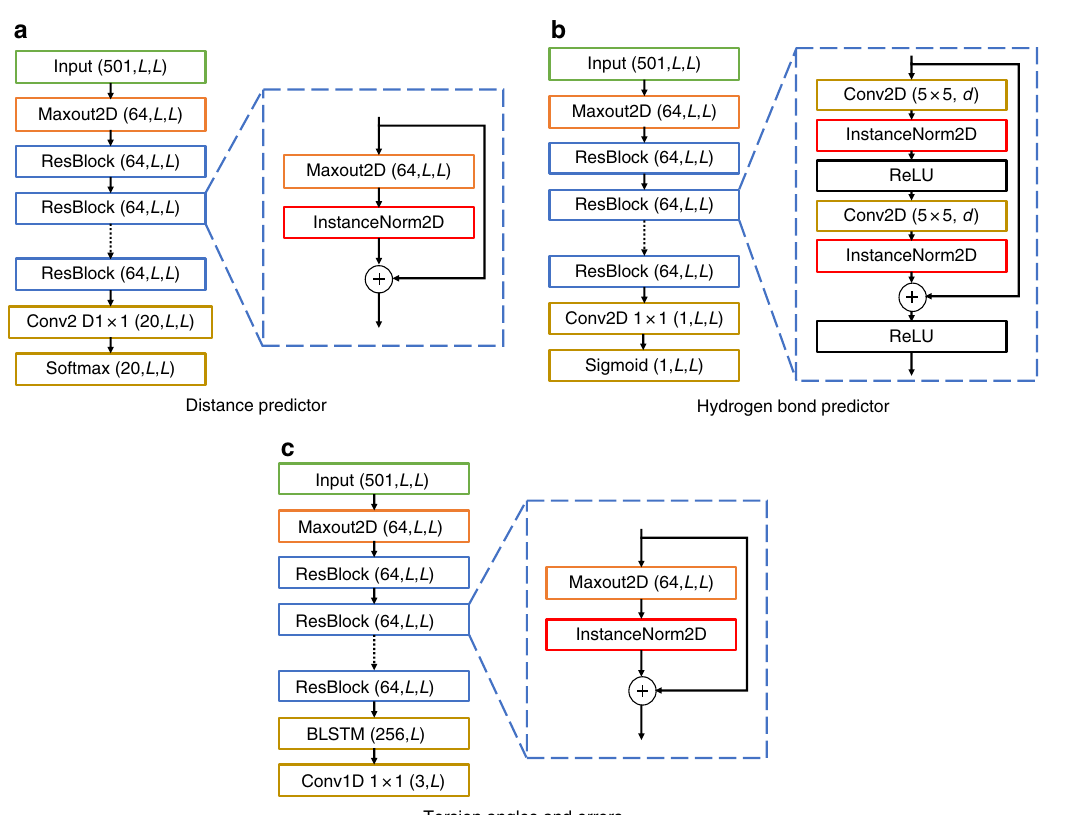
Fig. 9 DMPfold model architectures. DMPfold uses three predictors, all of which are deep, fully convolutional residual networks. Each uses a total of 18 residual blocks, comprising convolutional layers with a mixture of standard and dilated 5 × 5 fi lters. Where numbers are included in parentheses, these are the dimensions of the tensor output by the respective layer. For the iterative versions of the distance and H-bond predictors, the input tensor includes an extra feature channel composed of values taken from structures in the prior iteration (for a total of 502 channels). See the Methods section for full